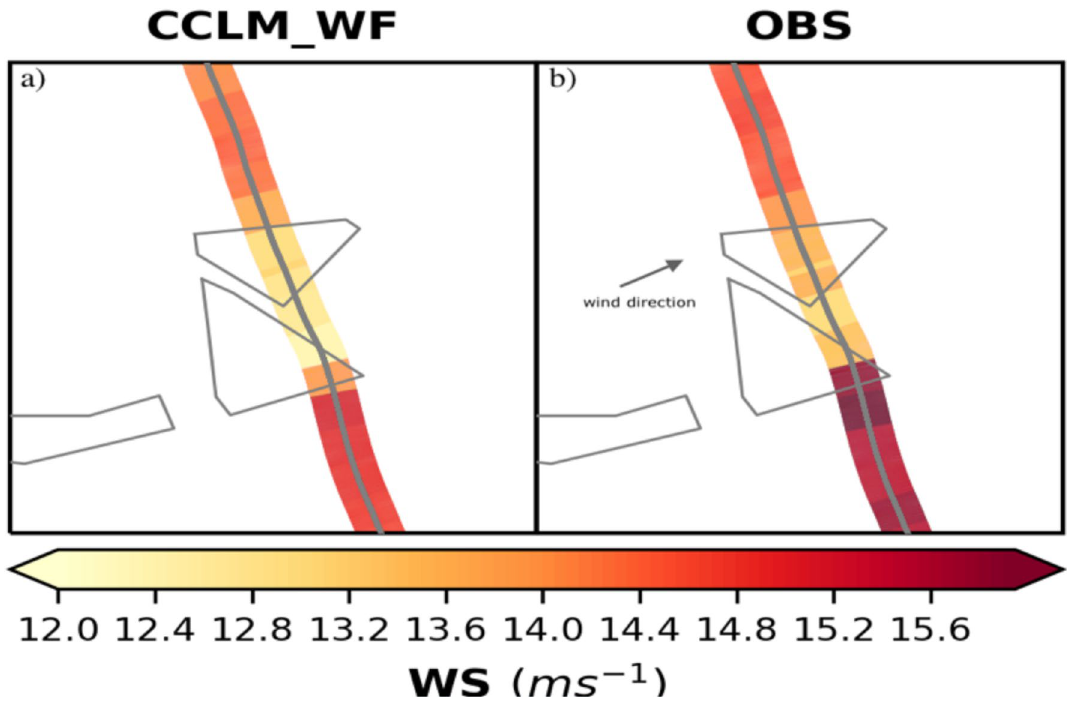
Figure 4. Wind speed at a height of 250 m ( a ) simulated in CCLM_WF and ( b ) observed by aircraft measurements. The aircraft track shown here ranged from 1445 to 1500 UTC on 14 October 2017. Arrow indicates the wind direction. The model simulations show the wind speed at 1500 UTC.